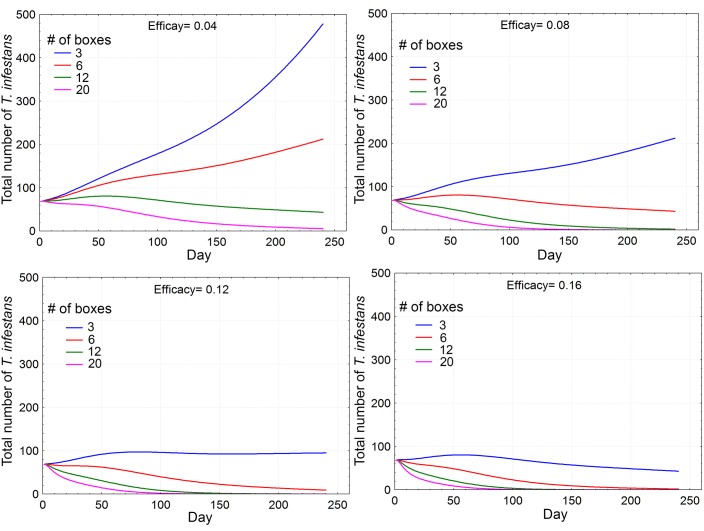
Combination of the Efficacy factor (E) and the number of boxes per house (n) to maintain the net population growth rate (RoP) within a band of ±10% around 1.